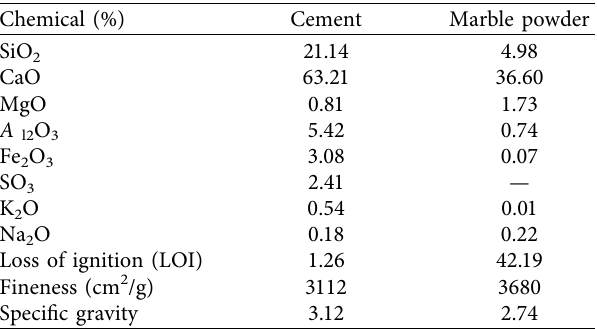
Table 1: Chemical properties of cement powder and powdered marble.